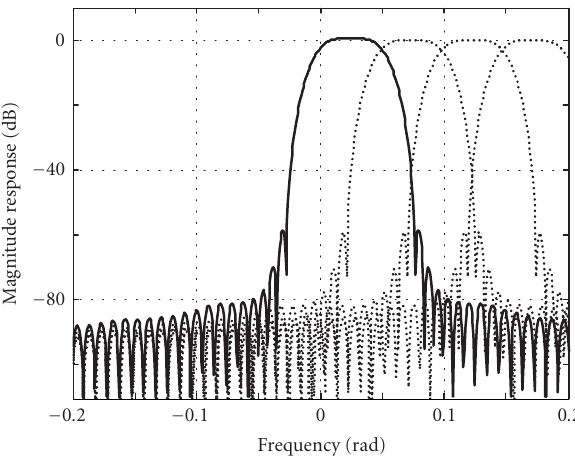
Figure 8: Magnitude responses of the first 4 of the 64-band SBR complex-exponential modulated analysis filter bank. The magni- tude for k = 0 is